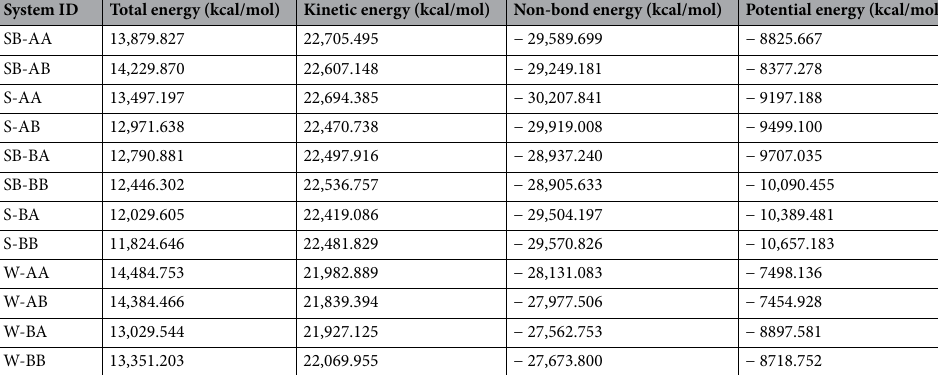
Table 3. Energy components of the system after the equilibration stage at 498